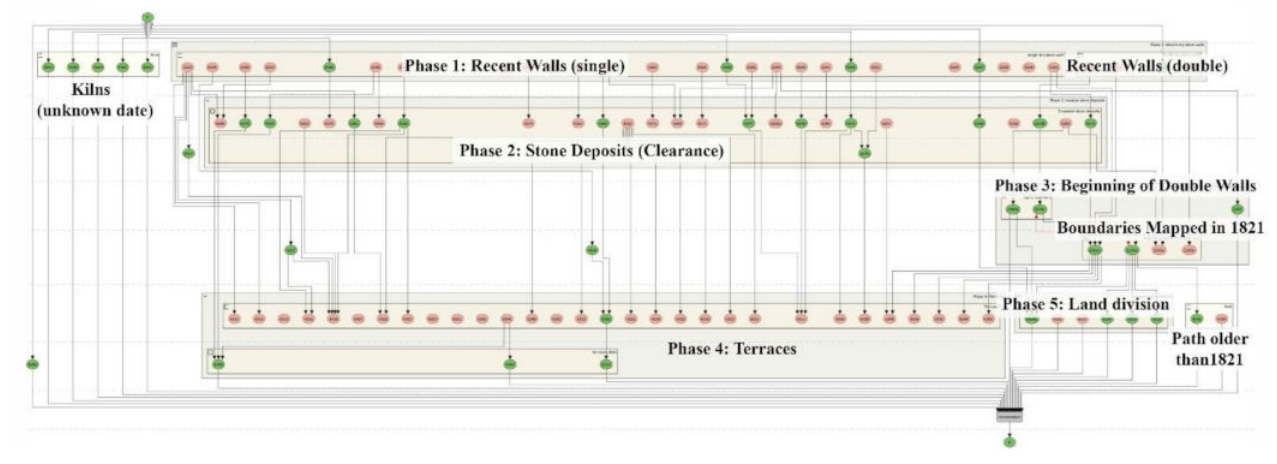
Figure 11. Final Harris Matrix of features in the case study